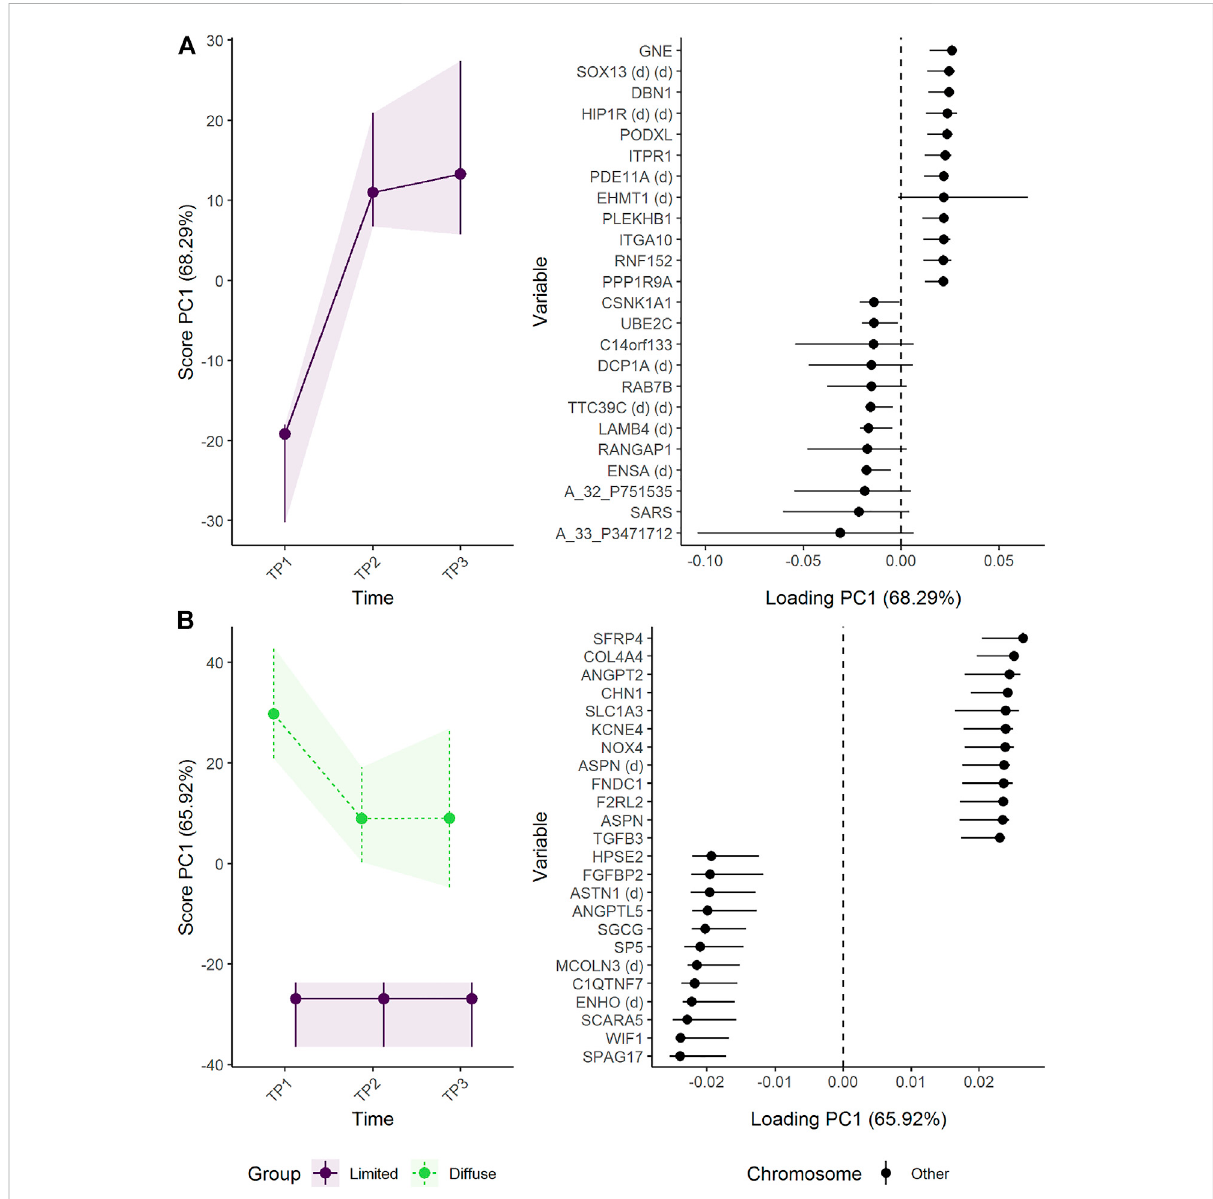
FIGURE 12 Time development of skin biopsy genome in patients with limited or diffuse systemic sclerosis. (A) The time development of patients with limited systemic sclerosis is isolated in the upper panels, whereas (B) the lower panels visualize how the skin biopsy genome develop distinctly between the groups. The expression of genes with high loadings is increasing when the scores increase and vice versa . Only the 12 genes with highest and lowest loadings, separated by the vertical dotted line, are shown due to the large number of assessed